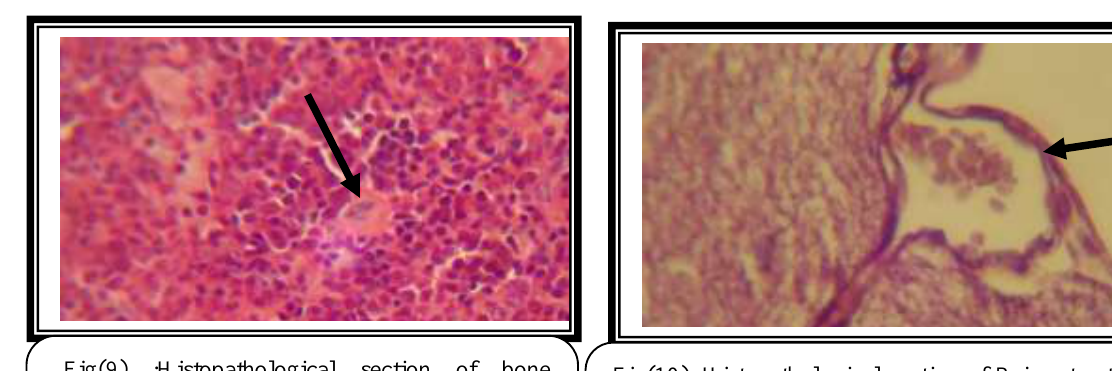
Fig(9) :Histopathological section of bone marrow of mouse treated with ethanolic extract of grape seed at dose (100mg/kg b.w orally) showing hemopoietic tissue with increase in numbers of megakaryocytes (H & E x400).